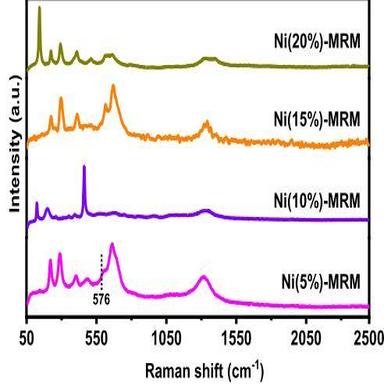
Raman spectra of Ni-MRM materials with variation in Ni-loading.